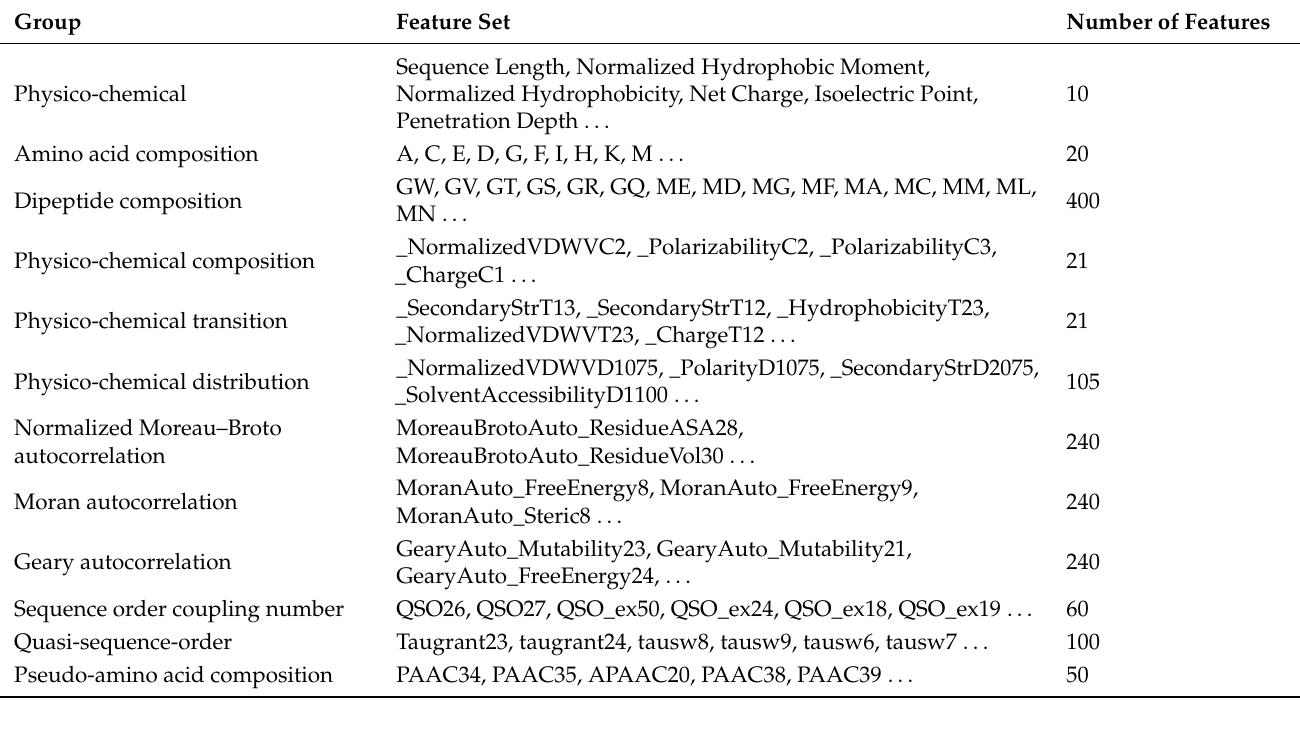
Table 1. A list of feature groups and the features that are associated with them, based on [2,38].